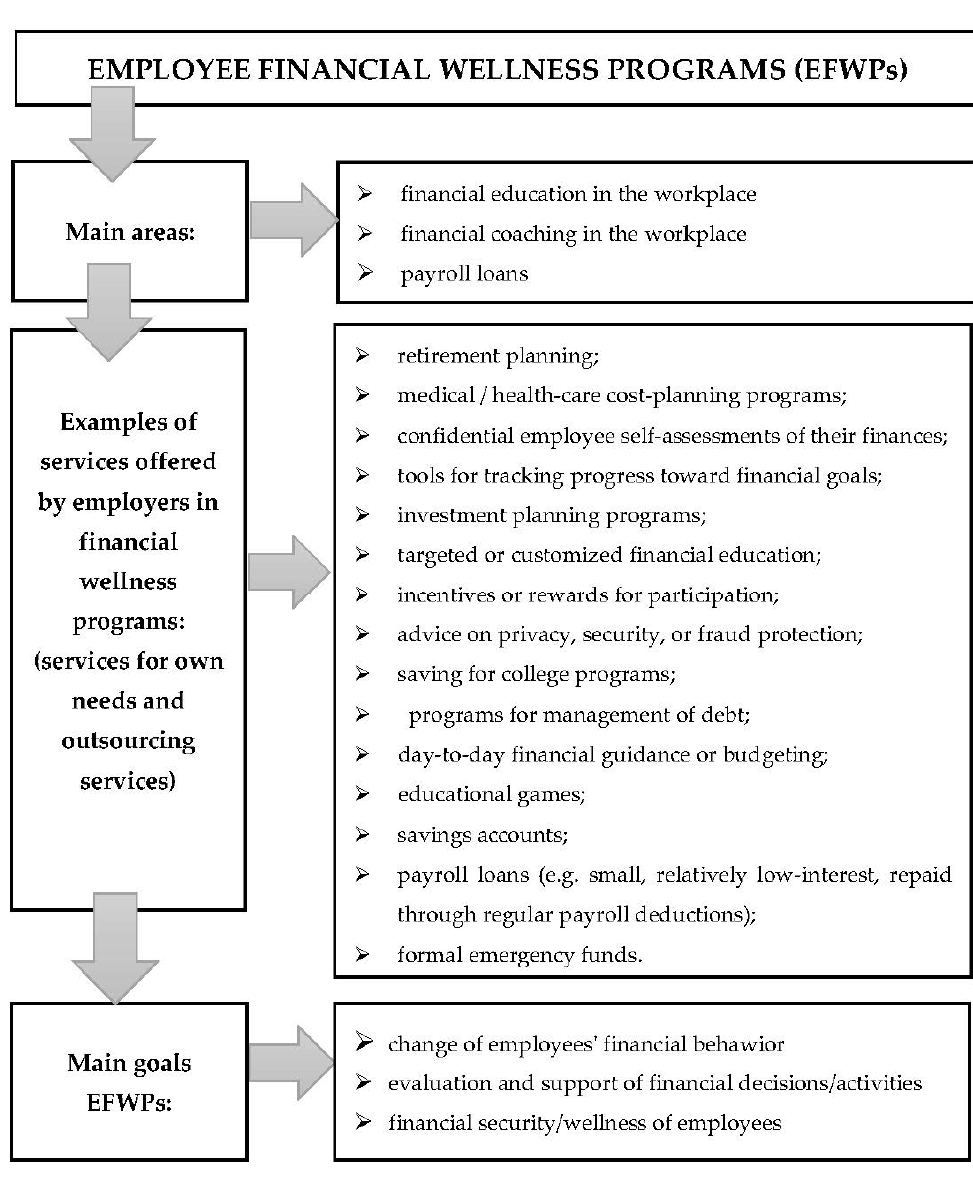
Figure 1. Elements of Employee Financial Wellness Programs structure. Source: Own study.